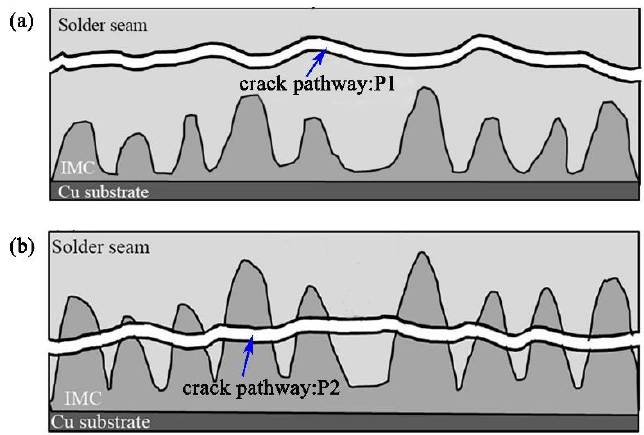
Figure 13. Schematic drawing illustrates of fracture model. ( a ) Crack propagation after 100cycle; ( b ) Crack propagation after 500 cycles.